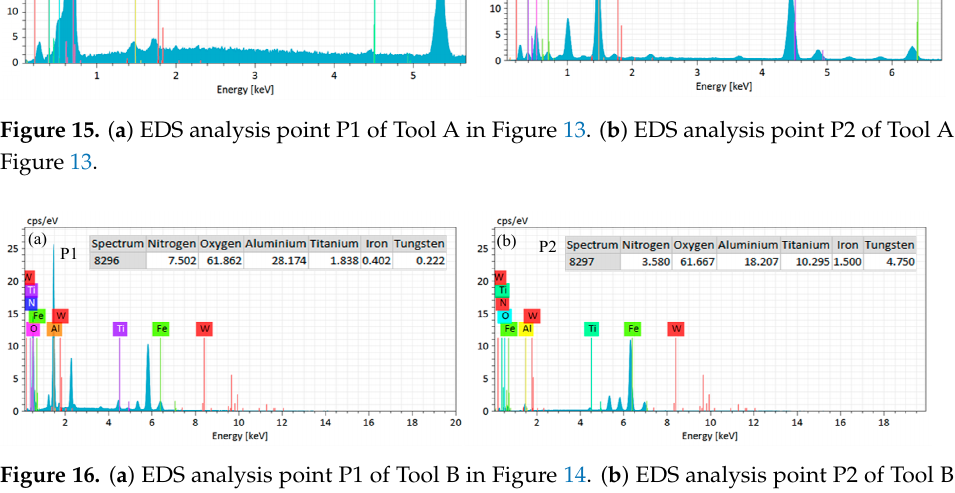
Figure 16. ( a ) EDS analysis point P1 of Tool B in Figure 14. ( b ) EDS analysis point P2 of Tool B in Figure 14.